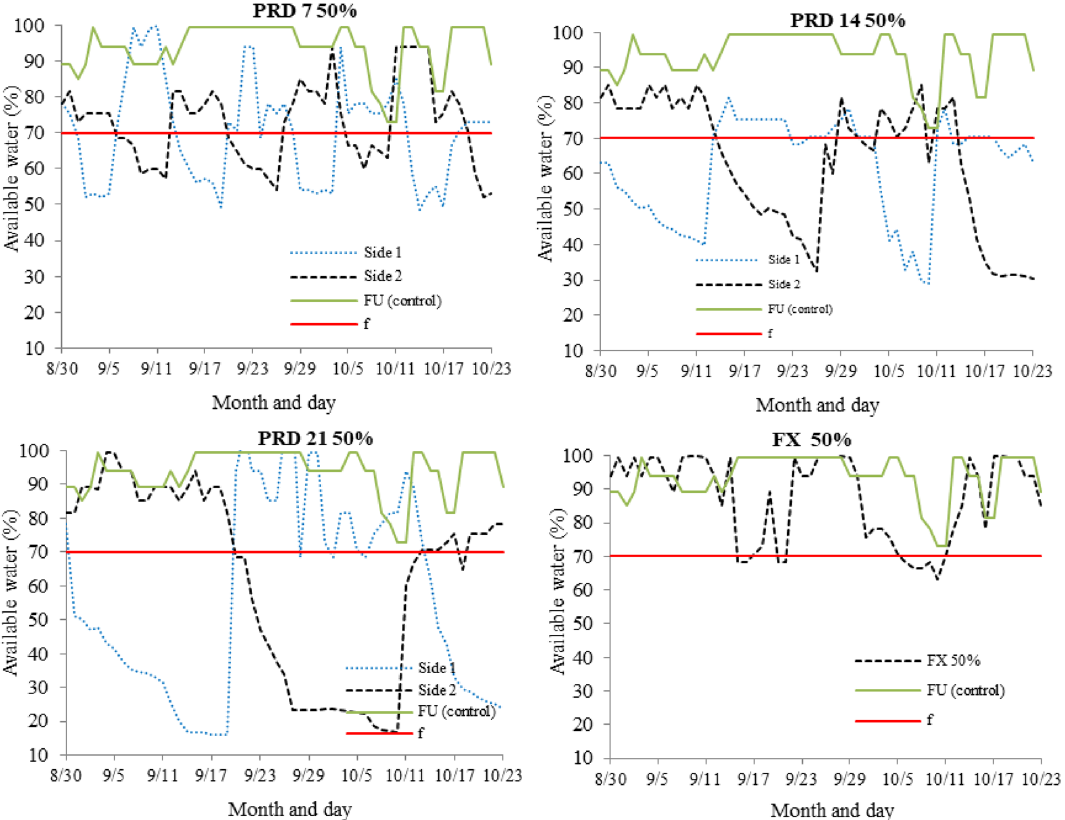
Figure 6. Available water in the soil under the different PRD irrigation regimes: partial rootzone drying, with 50% reduction in the water irrigation depth (WID), alternating at 7, 14 and 21 days; FX: fixed irrigation on one side of the rootzone, with 50% reduction in WID; FU: full irrigation, 100% of WID, and f: lower limit of soil water availability for papaya, in